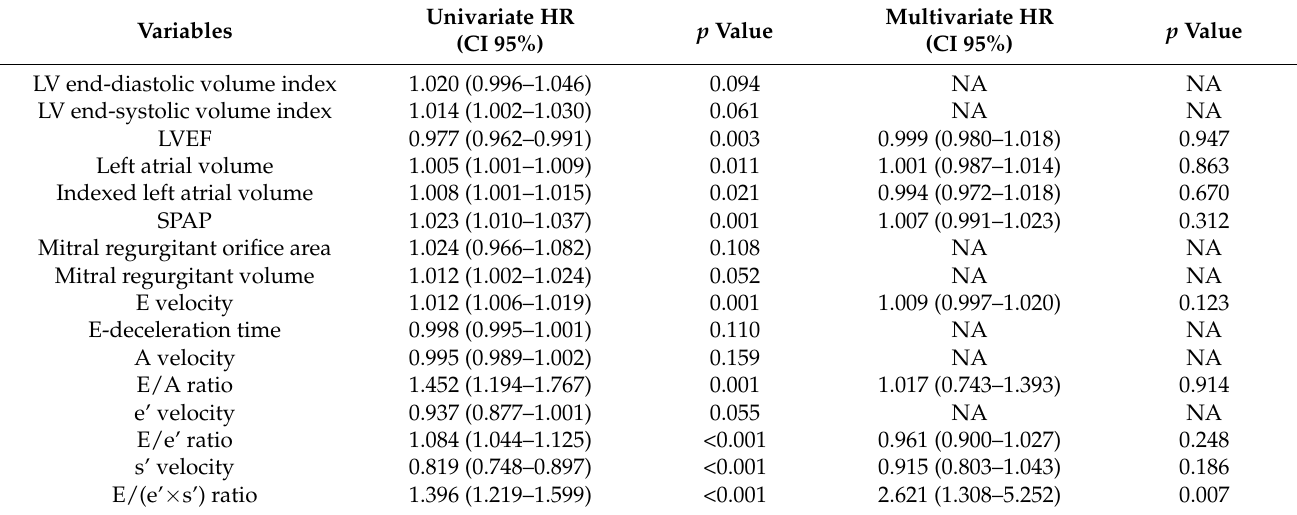
AA = peak late diastolic transmitral velocity; CI = confidence interval; E = peak early diastolic transmitral velocity; e’ = peak mitral annular diastolic velocity; HR = hazard ratio; LVEF = left ventricular ejection fraction; s’ = peak systolic velocity of mitral annulus; NA = not applicable; SPAP = systolic pulmonary artery